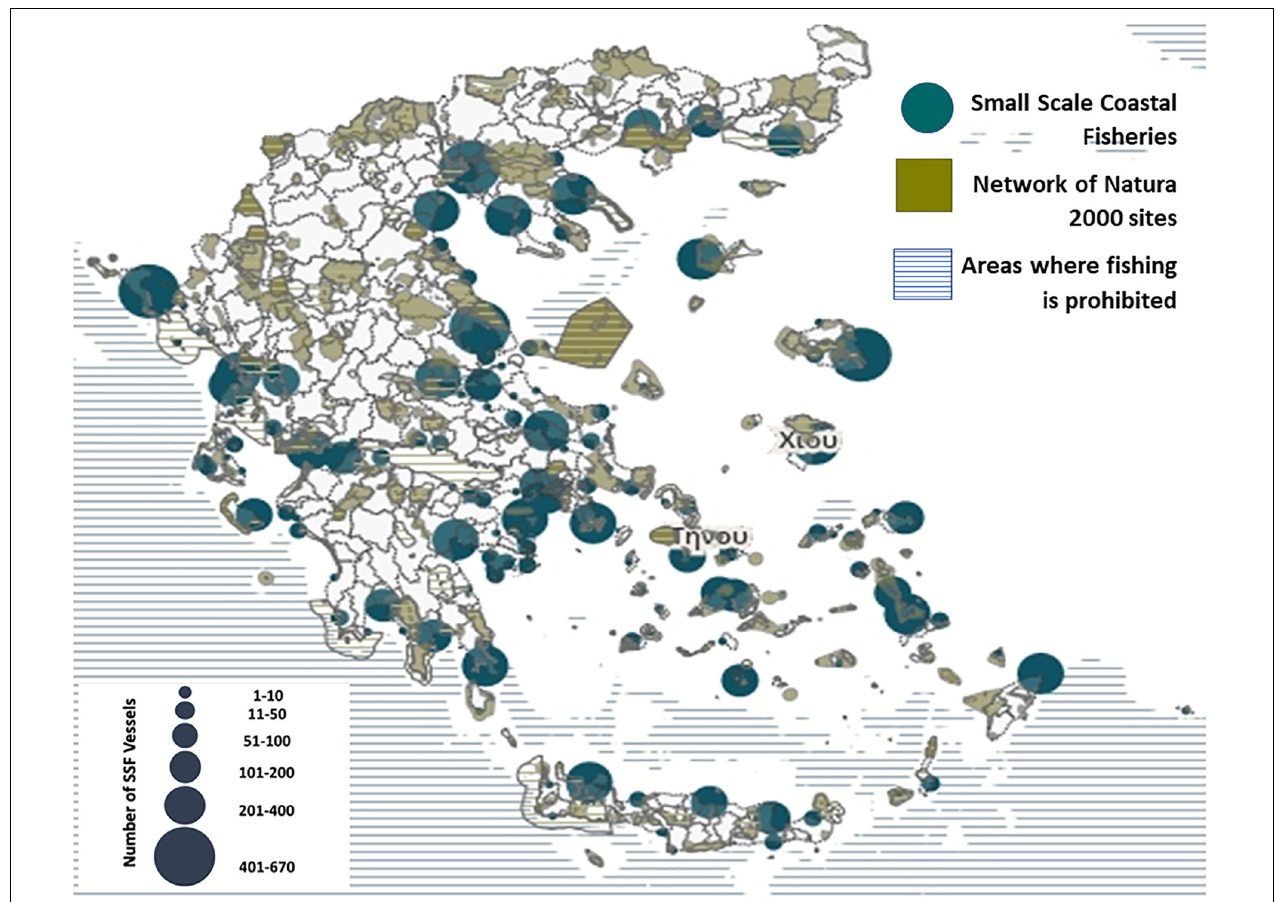
FIGURE 1 | Small-scale coastal fishing areas and the Network of Natura 2000 sites in Greece. Source: Own elaboration by authors based on data from the WWF Web Mapping Application “OIKOSKOPIO.GR”,